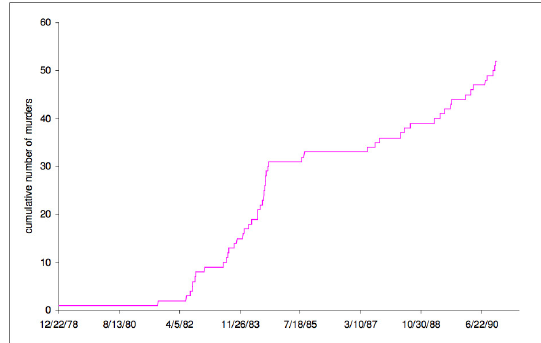
Figure 1. The plot of the cumulative number of murders committed by Chikatilo over 12 years, which is a Devil’s staircase [24].